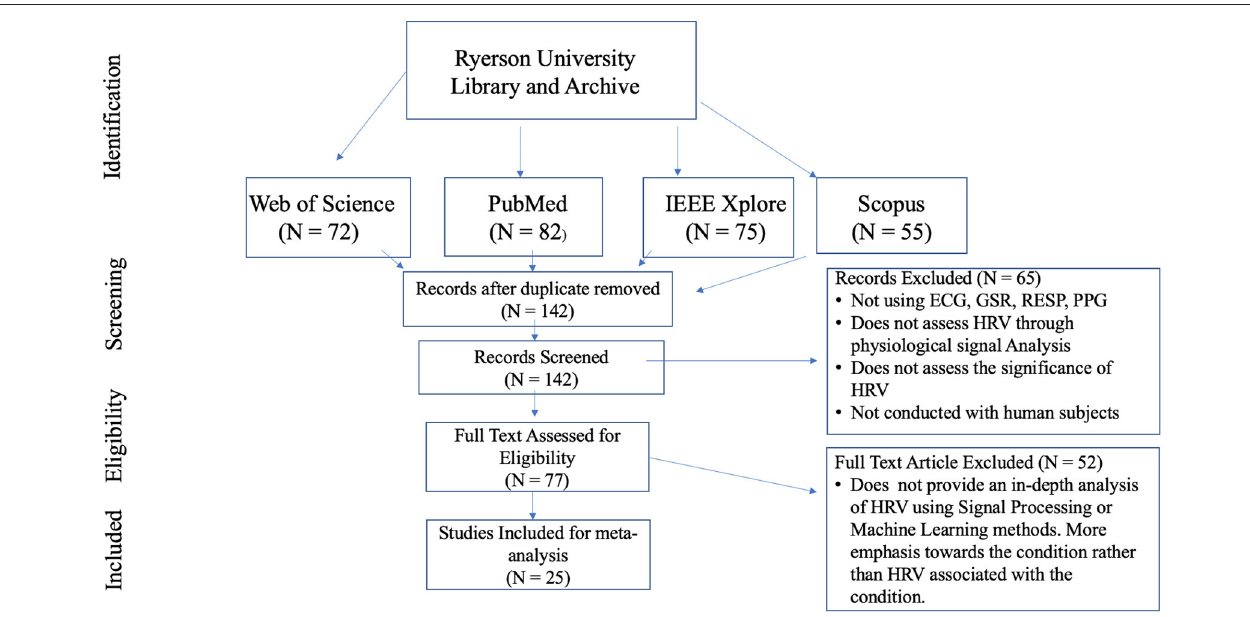
FIGURE 2 | Flow chart for HRV article selections which were used for meta-analysis.